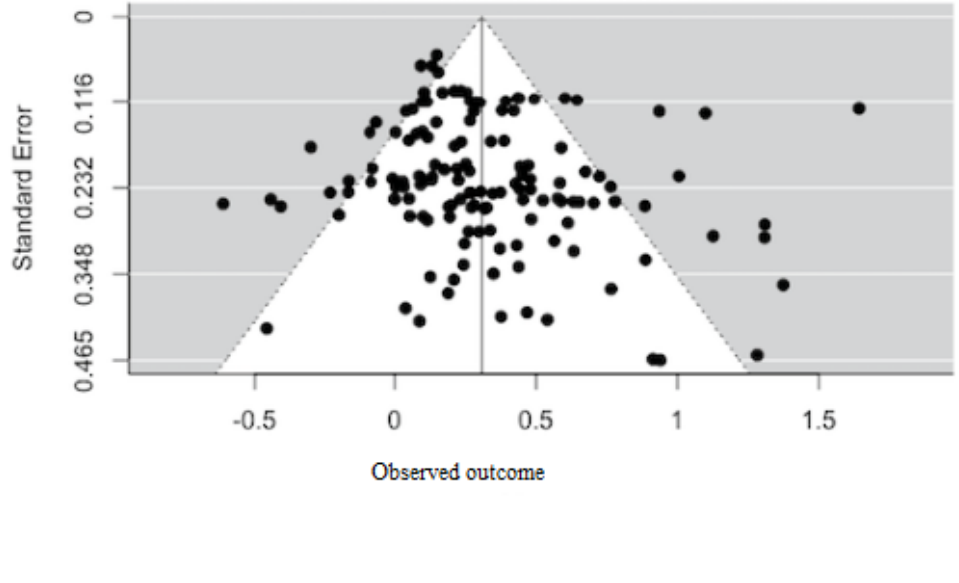
Figure 2. Funnel plot of effect sizes to check publication bias for this